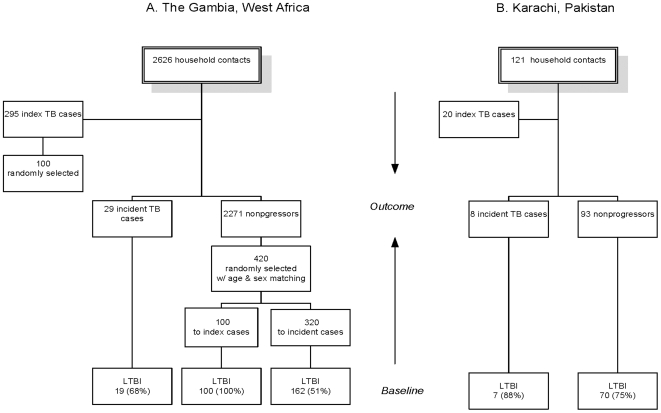
Samples recruited for H. pylori testing from Tuberculosis Case-Contact Studies.Blood samples were recruited for H. pylori serology testing from the specimen banks of tuberculosis case- contact studies carried out in (A) The Gambia, West Africa (Ref. 13,16), and (B) Karachi, Pakistan (Ref 14). Each study followed household members exposed to an active (index) case of tuberculosis for at least 2 years. Eligible samples were from HIV-negative participants. Samples from Gambia were randomly selected in 2 groups to match household contacts by age and sex to index and incident TB cases, respectively. LTBI: latent tuberculosis infection at baseline, defined as TST ≥10mm or ELISPOT ≥8 SFU (Gambia), or as TST ≥10mm (Pakistan). Baseline characteristics are shown in Table S4.